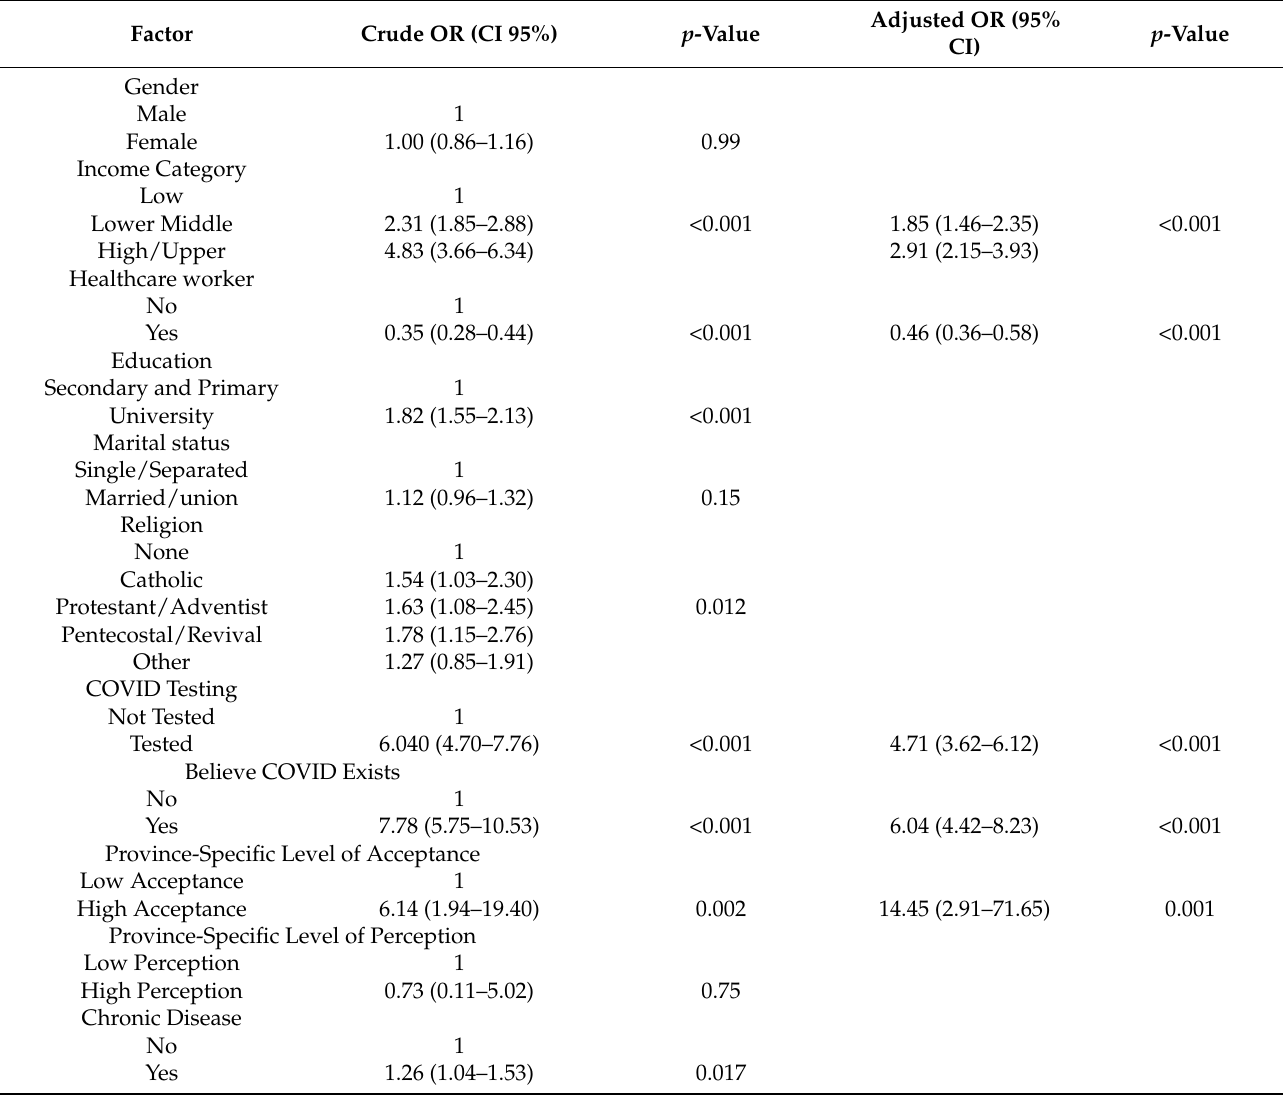
Table 3. Factors associated with COVID vaccine acceptance in the